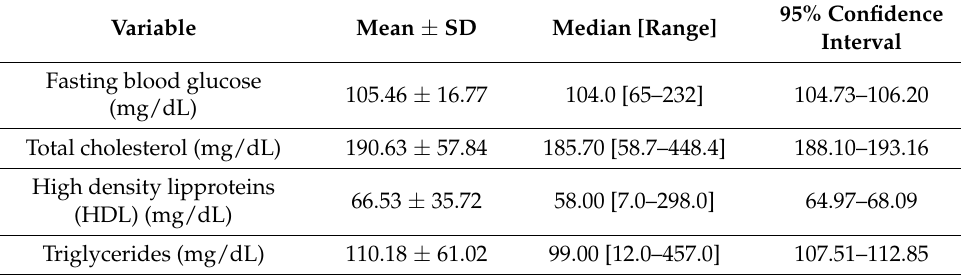
Table 5. Serum biochemistry of study subjects.